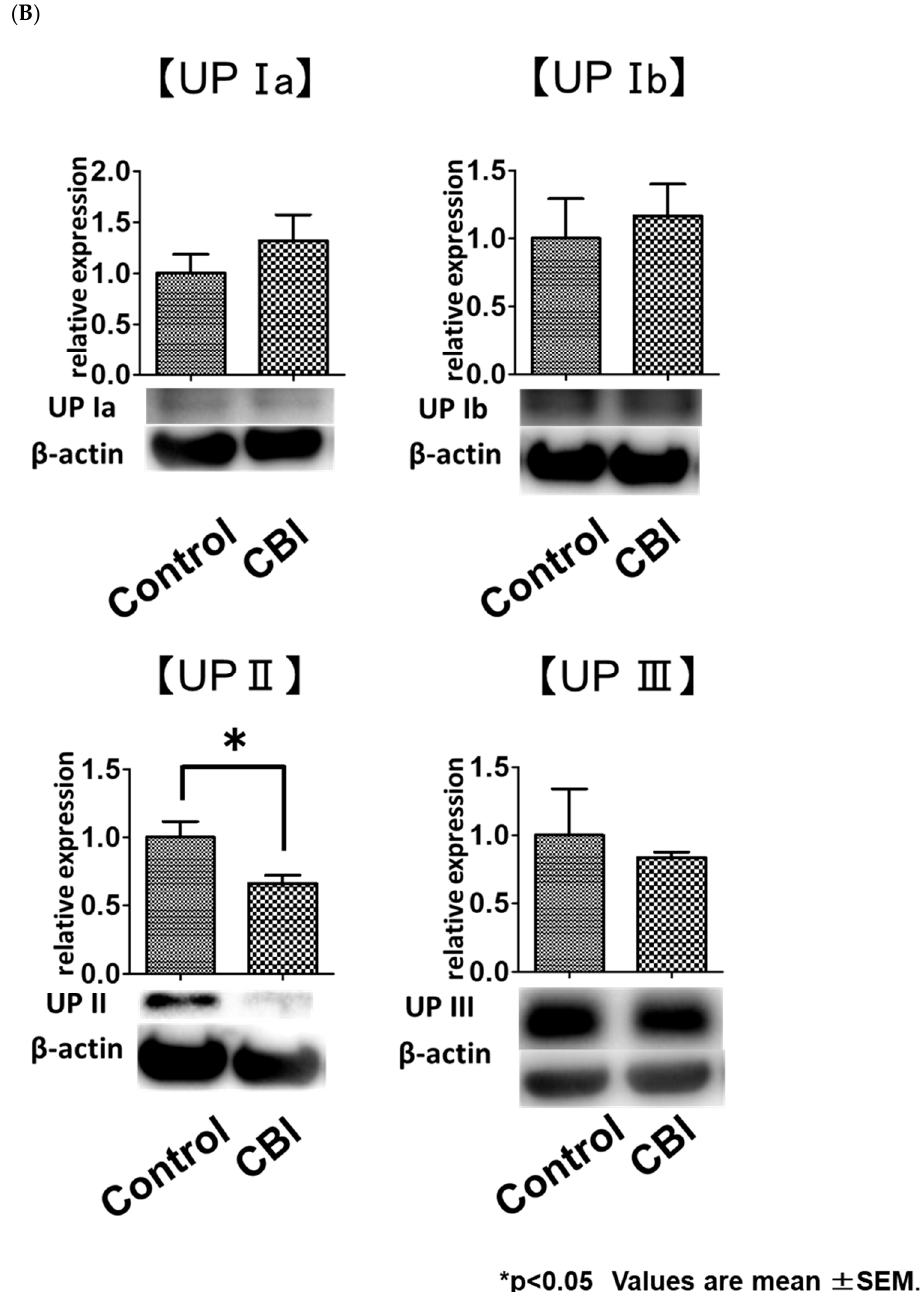
Figure 4. ( A ) Immunohistochemical examinations of the bladder specimens from the control and CBI groups (200 × magnification; scale bars 50 µ m). Bar graphs show the average percentage of UP-positive cells in the control and CBI groups. Values represent mean ± SEM. * p < 0.05 (Mann–Whitney U Test). ( B ) Expression of Uroplakins (UPs) at the protein level in the bladder according to Western blot. Each bar represents the mean ± SEM of 6–9 determinations, each from a different bladder. * p < 0.05 (Mann–Whitney U Test).